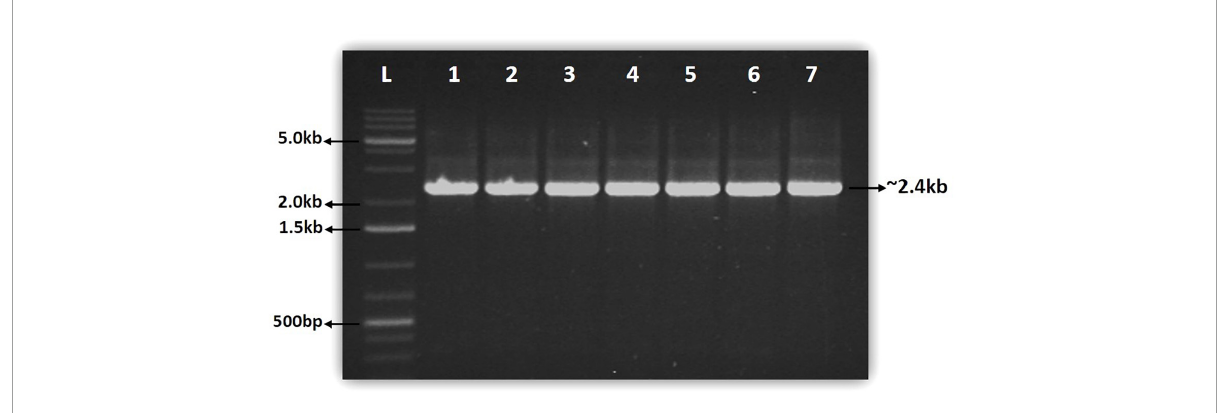
FIGURE1 Gel pictures showing the amplification of full length NAC gene from seven coffee species. Lane L: 1kb plus GeneRuler from Thermo Fischer Scientific, Lane 1: C. canephora (S.274), Lane 2: C. arabica (S.795), Lane 3: C. travancorensis , Lane 4: C. bengalensis Lane 5: C. wightiana Lane 6: C. jenkinsii Lane 7: C. khasiana